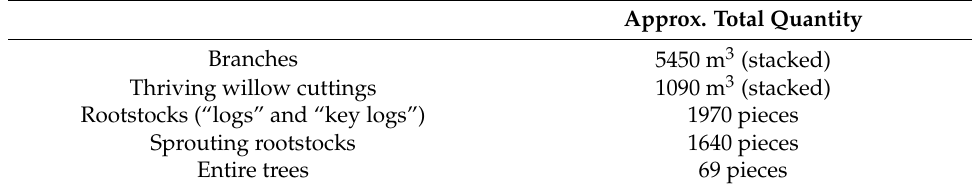
Table 2. Wood quantities used at the Emme River (Wehr Biberist-Aare).